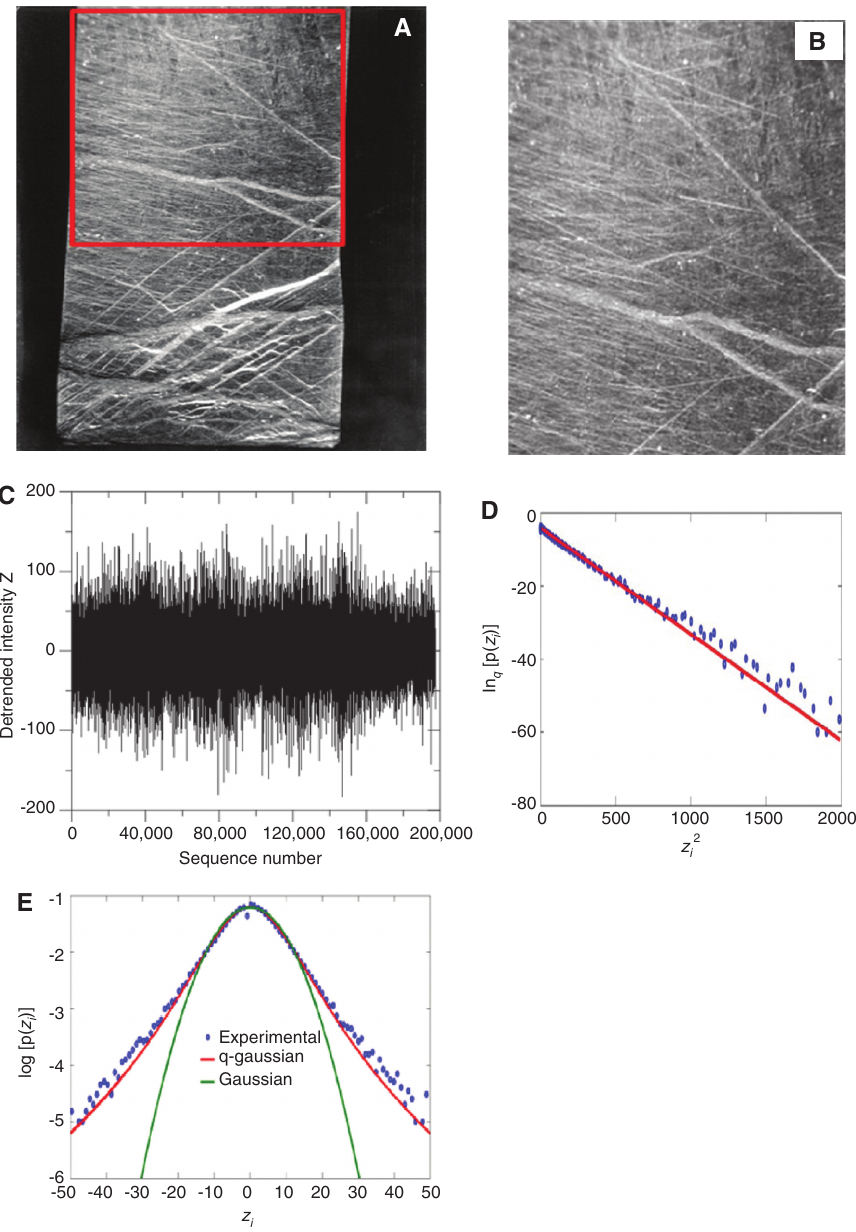
Figure 4: (A) A photograph showing shear band formation in the nanostuctured Fe-10% Cu alloy. (B) Enlarged view of shear banding corresponding to the area denoted in the red square in Figure 4A. (C) Detrended intensity series Z . (D) Best linear correlation between ln [ p ( z )] and ( z ) 2 for the image series. (E) log( p ( z q i i and the normal Gaussian (green